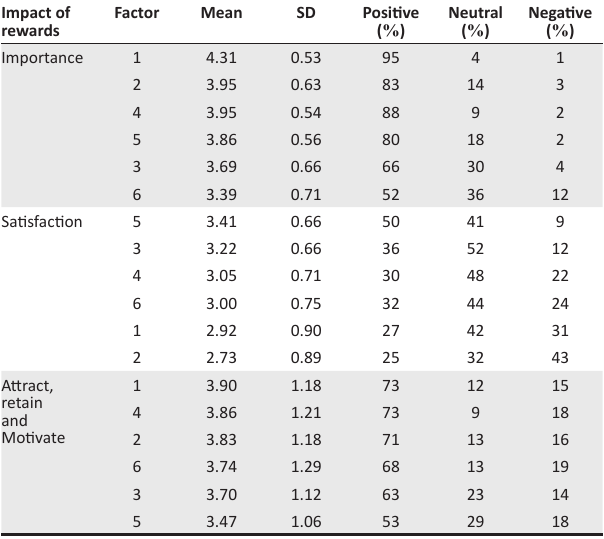
TABLE 4: Descriptive statistics for the reward category summated scores. Impact of